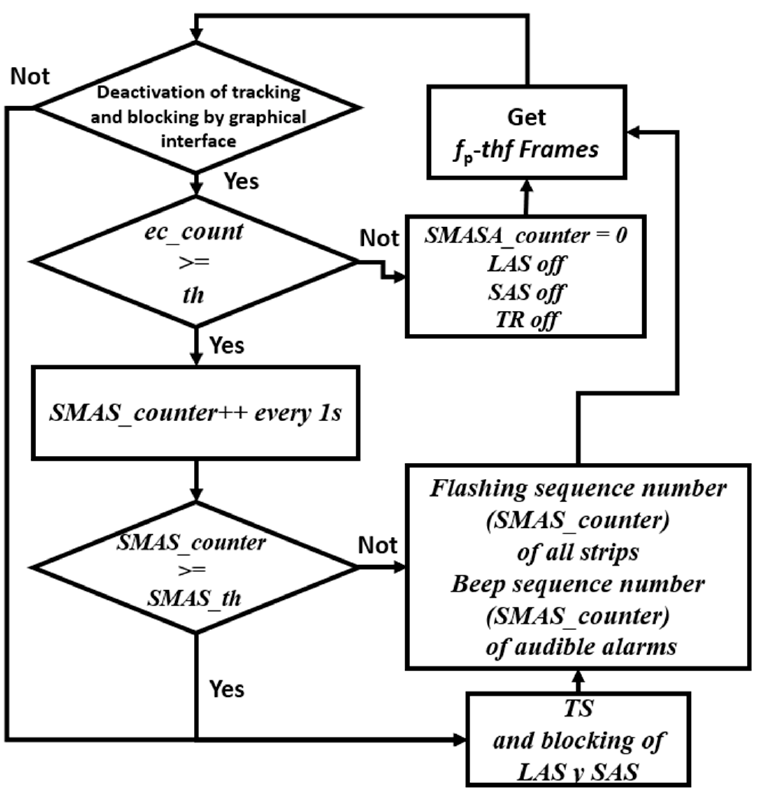
Figure 17. Activation and deactivation process of LAS, SAS, and TS for drowsiness detection.